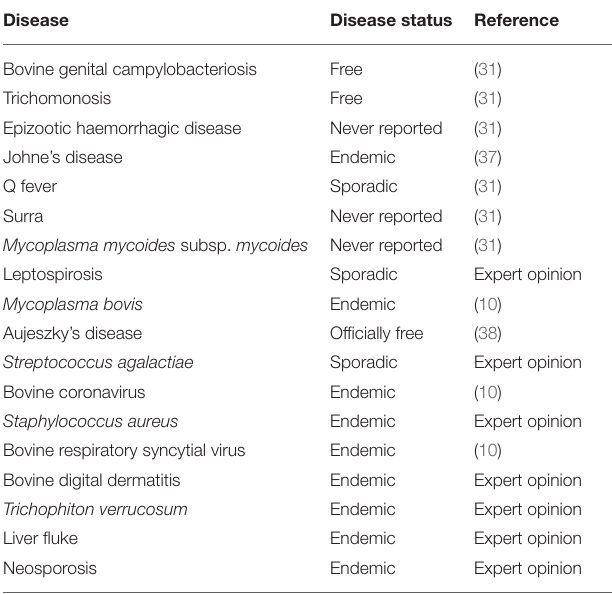
TABLE 2 | Disease status for Slovenia of cattle diseases listed under category C, D, or E in the Animal Health Law for which CPs exist in European countries. Disease Disease status